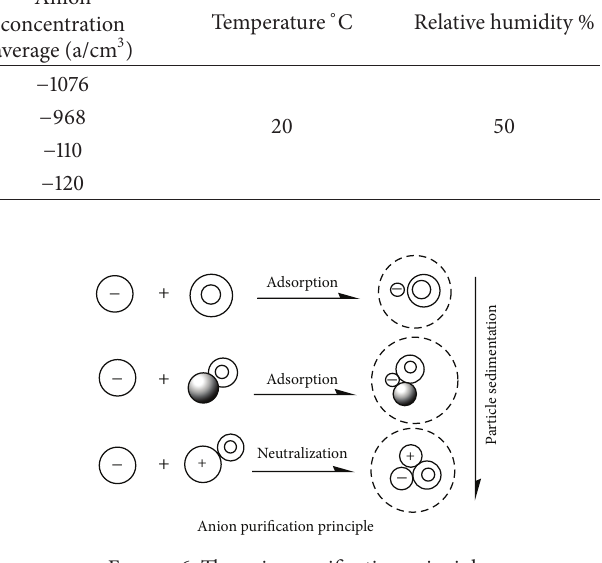
Figure 6: The anion purification